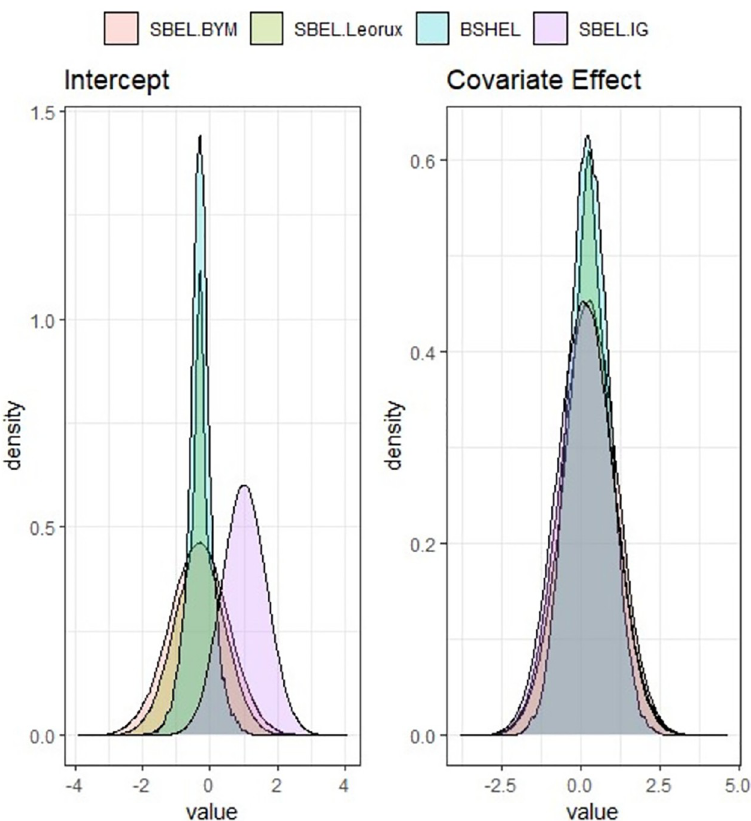
Fig 3. Posterior densities of regression coefficients β 0 and β 1 using BEL spatial models for North Carolina SIDS data.